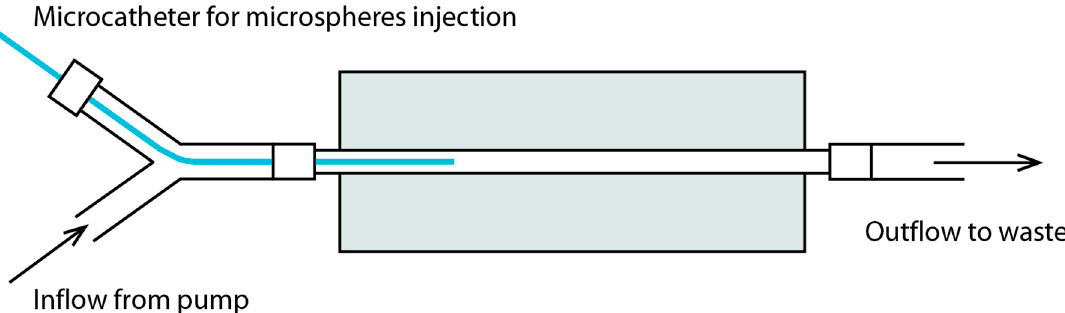
Figure 2. A schematic overview of the setup that was used to investigate the visibility of microspheres in a flow phantom. The grey box resembles the polyvinyl alcohol that is cast around the plastic tubing.